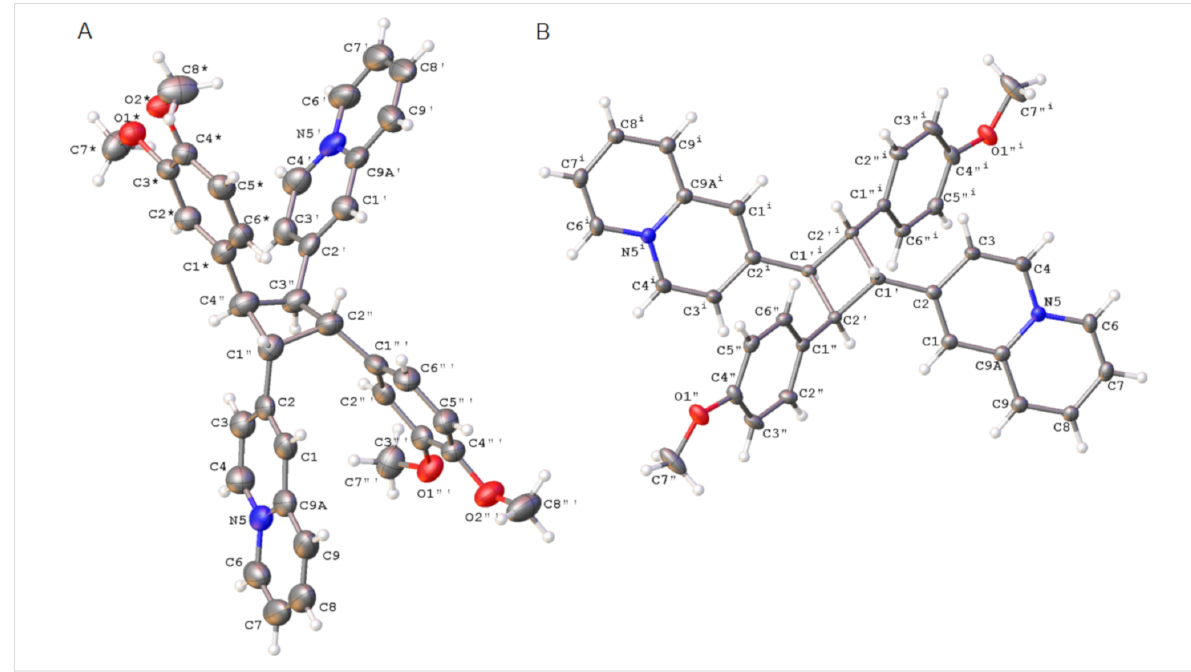
Figure 8: ORTEP drawings of cyclobutane derivatives 4b (A) and 4c (B) in the solid state (thermal ellipsoids indicate 50% probability). The tetra- fluoroborate counterions were omitted for clarity.